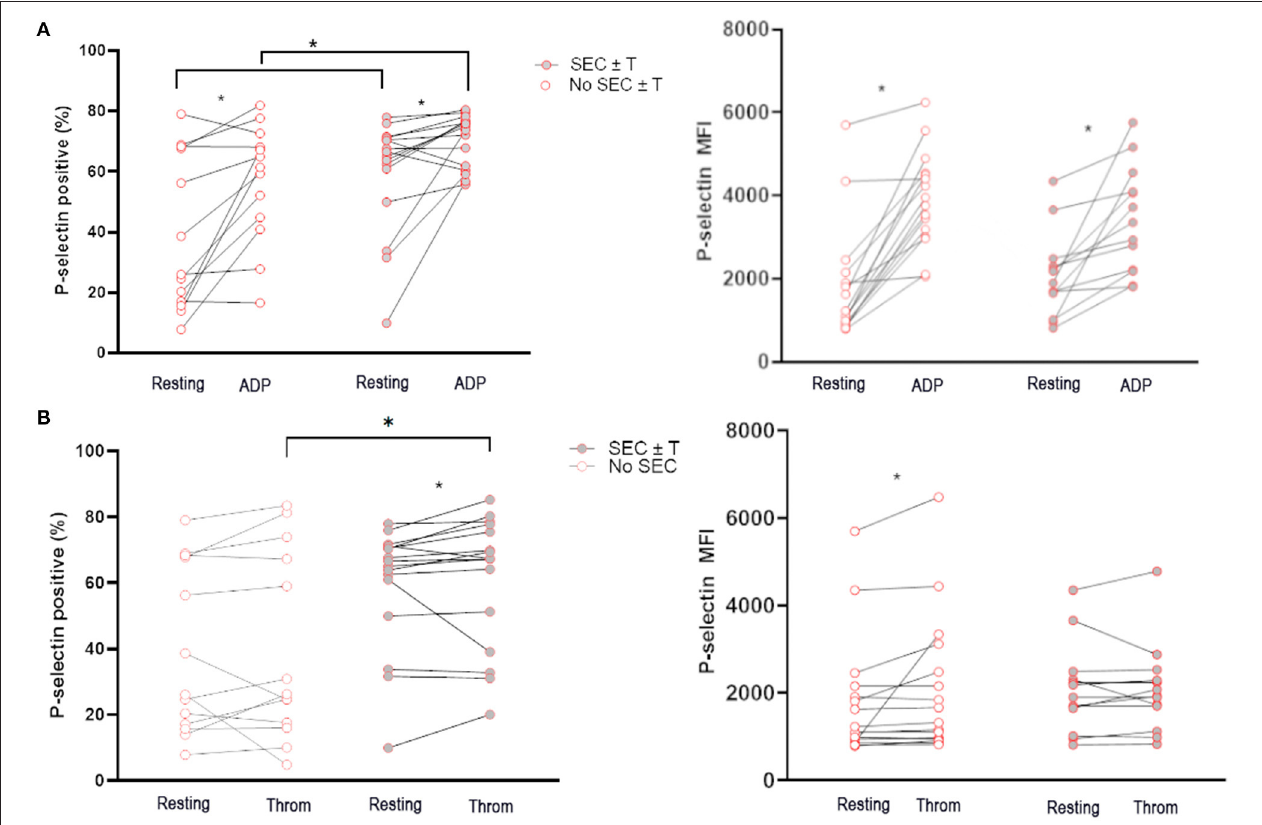
FIGURE 4 | Cats with naturally occurring wildfire related (WF) injuries had increased activated platelets and platelet priming. Platelet activation in 29 WF cats with or without spontaneous echocardiographic contrast with or without intracardiac thrombi (SEC ± T) was measured as either percentage of P-selectin-positive platelets or P-selectin median florescence intensity (MFI) at rest, or in the presence of 20 µ M ADP (A) or 0.01 U/ml thrombin (B) . (A) Cats with SEC ± T had increased amount of P-selectin positive platelets in unstimulated (resting) platelets. (A,B) There was also evidence of increased platelet priming in cats with SEC ± T given that higher percentages of P-selectin positive platelets were found in cats with SEC ± T compared to those without following treatment of platelets with ADP or thrombin. * p <